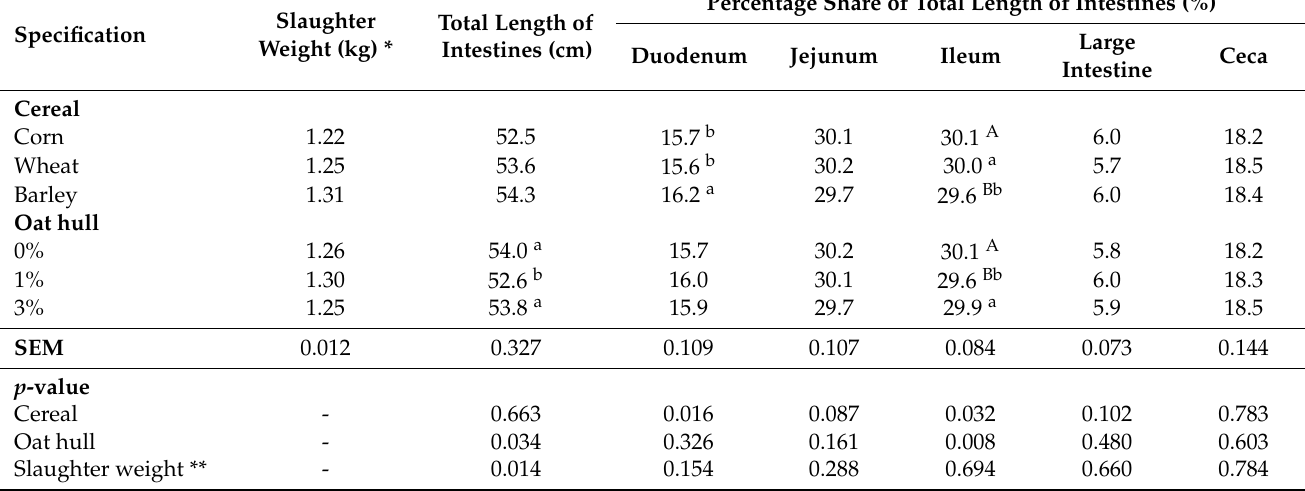
Table 7. Percentage share of total length of intestines recalculated for metabolic weight (BW 0.67 ) in broiler chickens.